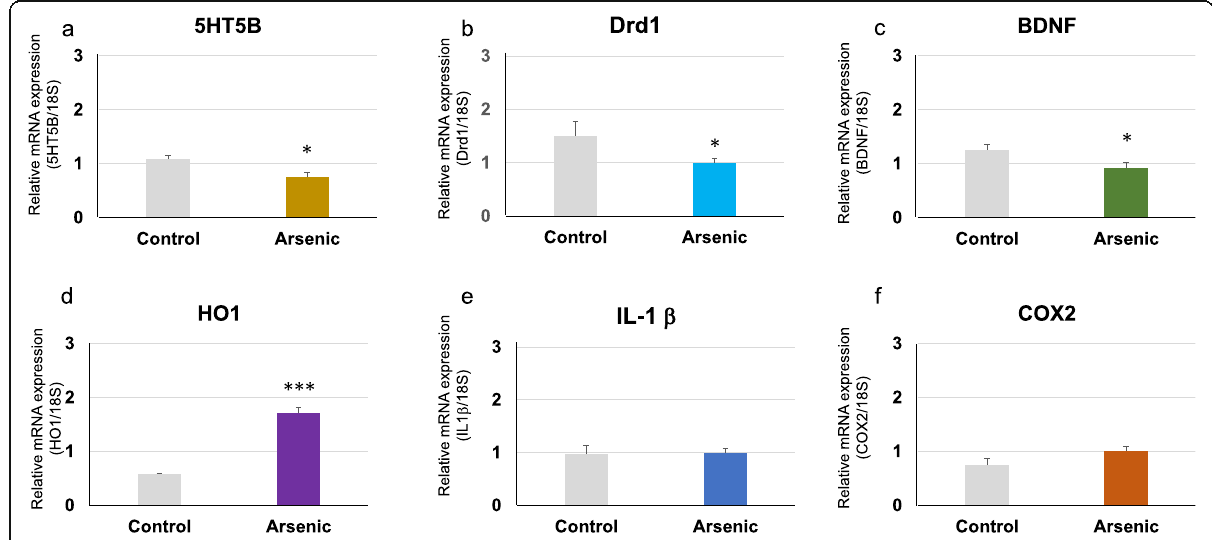
Fig. 6 Messenger RNA expression level. a 5-HT 5B, b Drd1a, c BDNF, d HO-1, e IL-1 β , and f COX-2 in the prefrontal cortex of the control group and the arsenic group of 74-week-old F2 male mice. Each bar represents the mean ± SE ( n = 7 – 11, * p < 0.05, *** p <